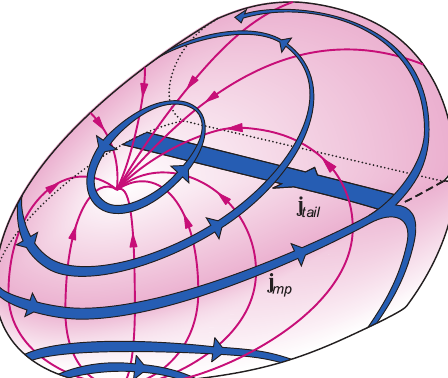
Figure 1. Three-dimensional geometry of day-side magnetopause currents. Figure courtesy of Wolfgang